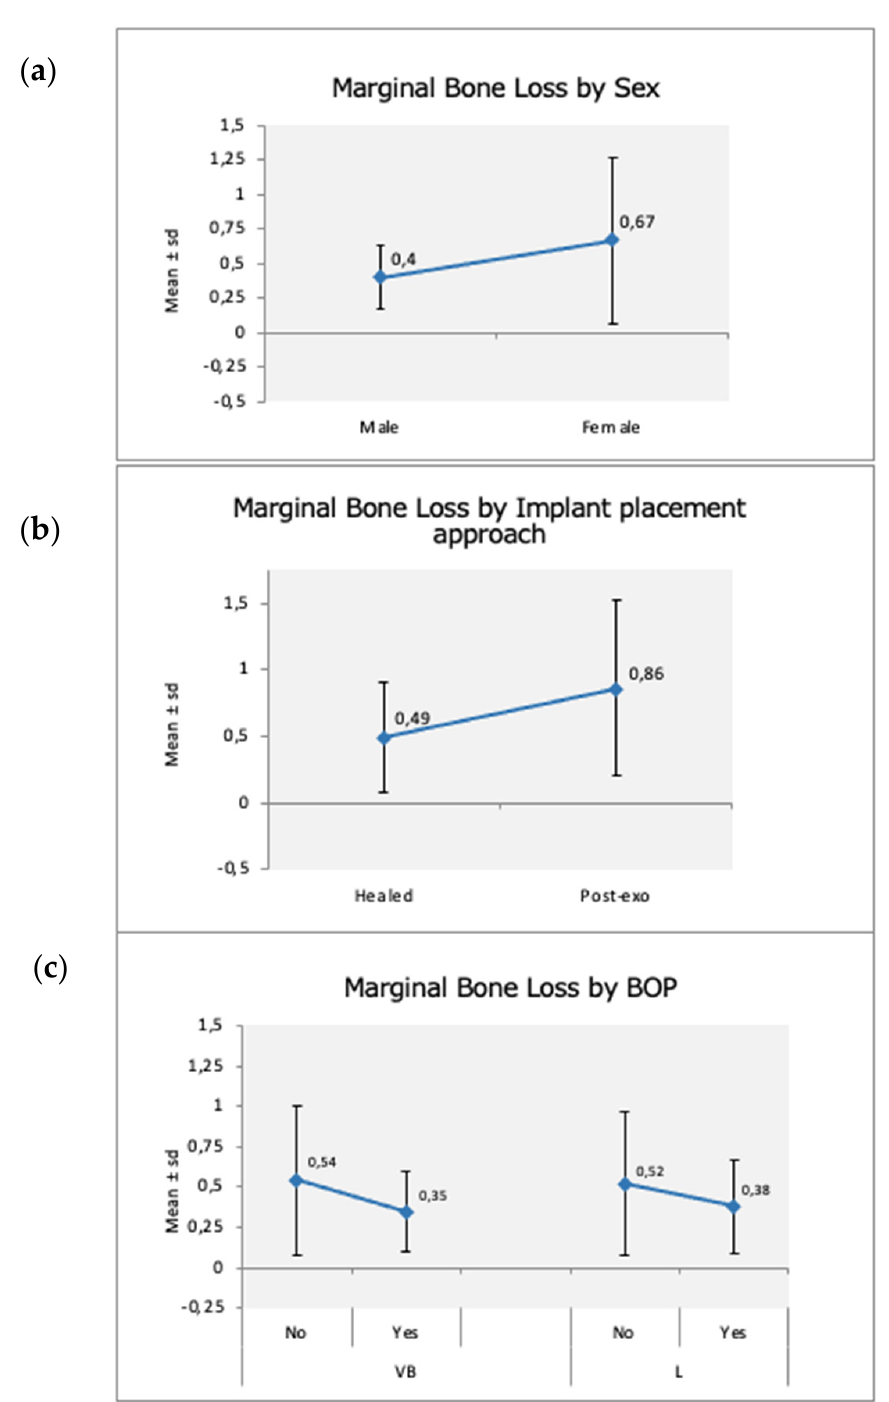
Figure 3. Significant clinical and patient-level parameters associated with MBL at 1-year follow-up. ( a ) MBL vs. gender; ( b ) MBL vs. timing of implant placement (healed ridge vs. post-extraction site); and ( c ) MBL vs. BoP.